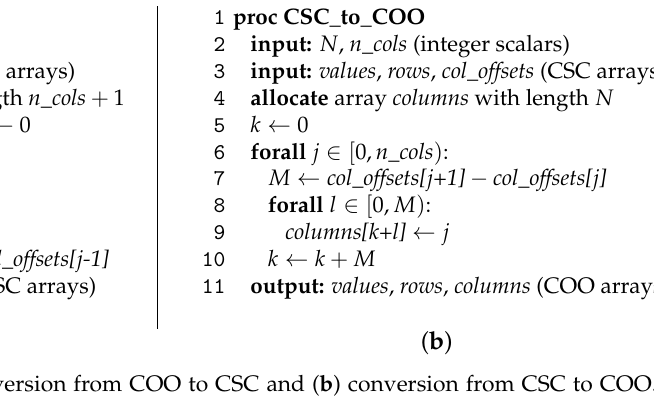
Figure 4. Algorithms for: ( a ) conversion from COO to CSC and ( b ) conversion from CSC to COO. Matrix elements in COO format are assumed to be stored in column-major ordering. All arrays and matrix locations use zero-based indexing. N indicates the number of non-zero elements, while n_cols indicates the number of columns. Details for the CSC and COO arrays are given in Section